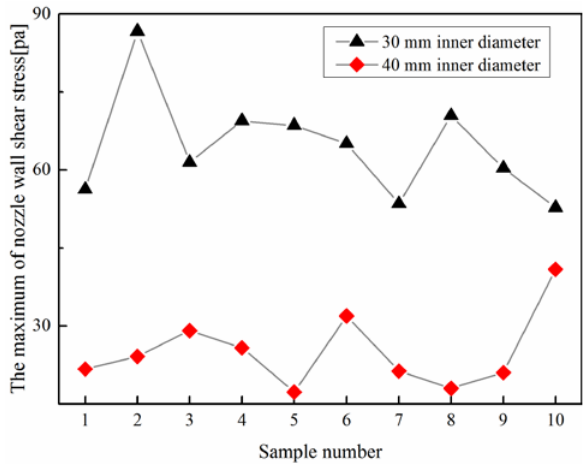
Figure 13. Maximum values of nozzle wall shear stress at varied inner diameters.